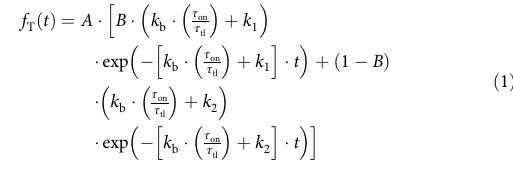
Blot protocol with the antibodies listed in Supplementary Table 3. The TBP- antibody was diluted between 1:500 and 1:250, the gamma-tubulin antibody was diluted between 1:100,000 and 1:10,000. Secondary antibody was diluted 1:10,000. To visualize binding of the secondary antibody, we incubated the blot with